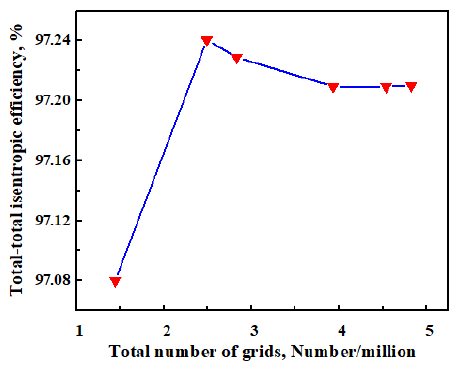
Figure 3. Grid independence verification.